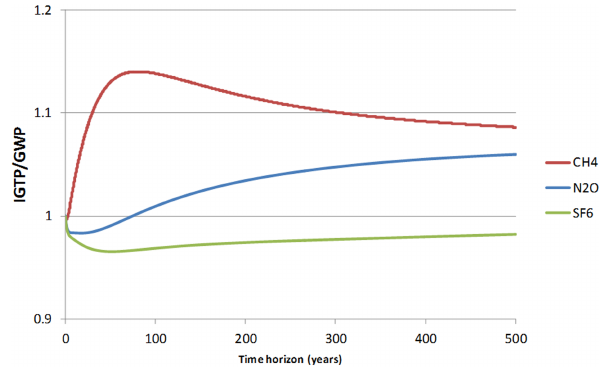
Fig. 1. IGTP/GWP ratio for CH 4 , N 2 O and SF 6 depending on the time horizon H (in